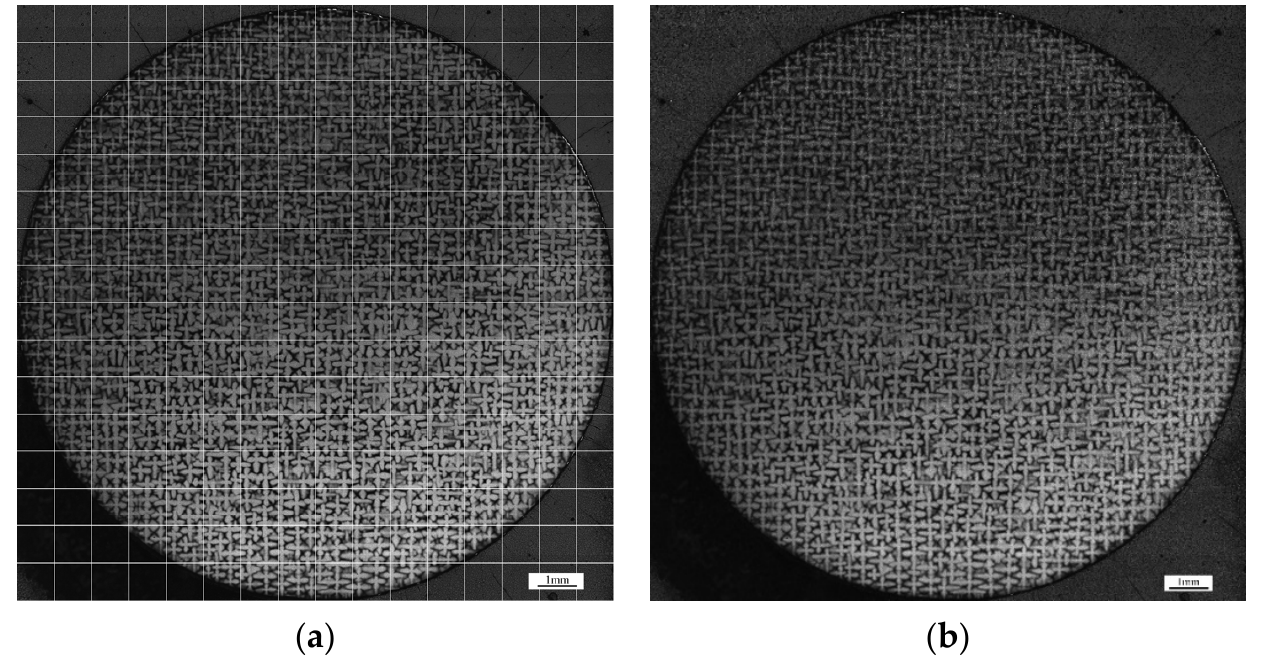
Figure 2. ( a ) Original multi-field images. ( b ) Stitched full-field image.